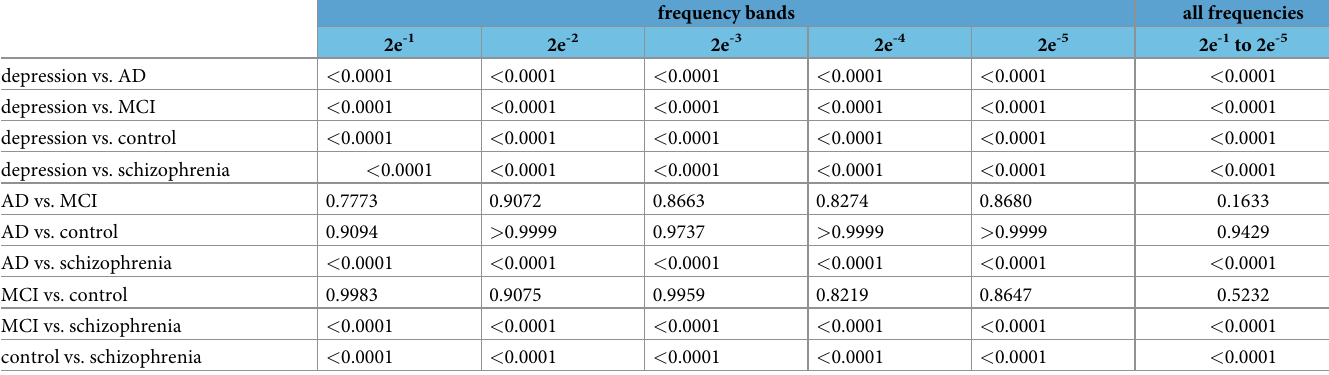
frequency bands all frequencies